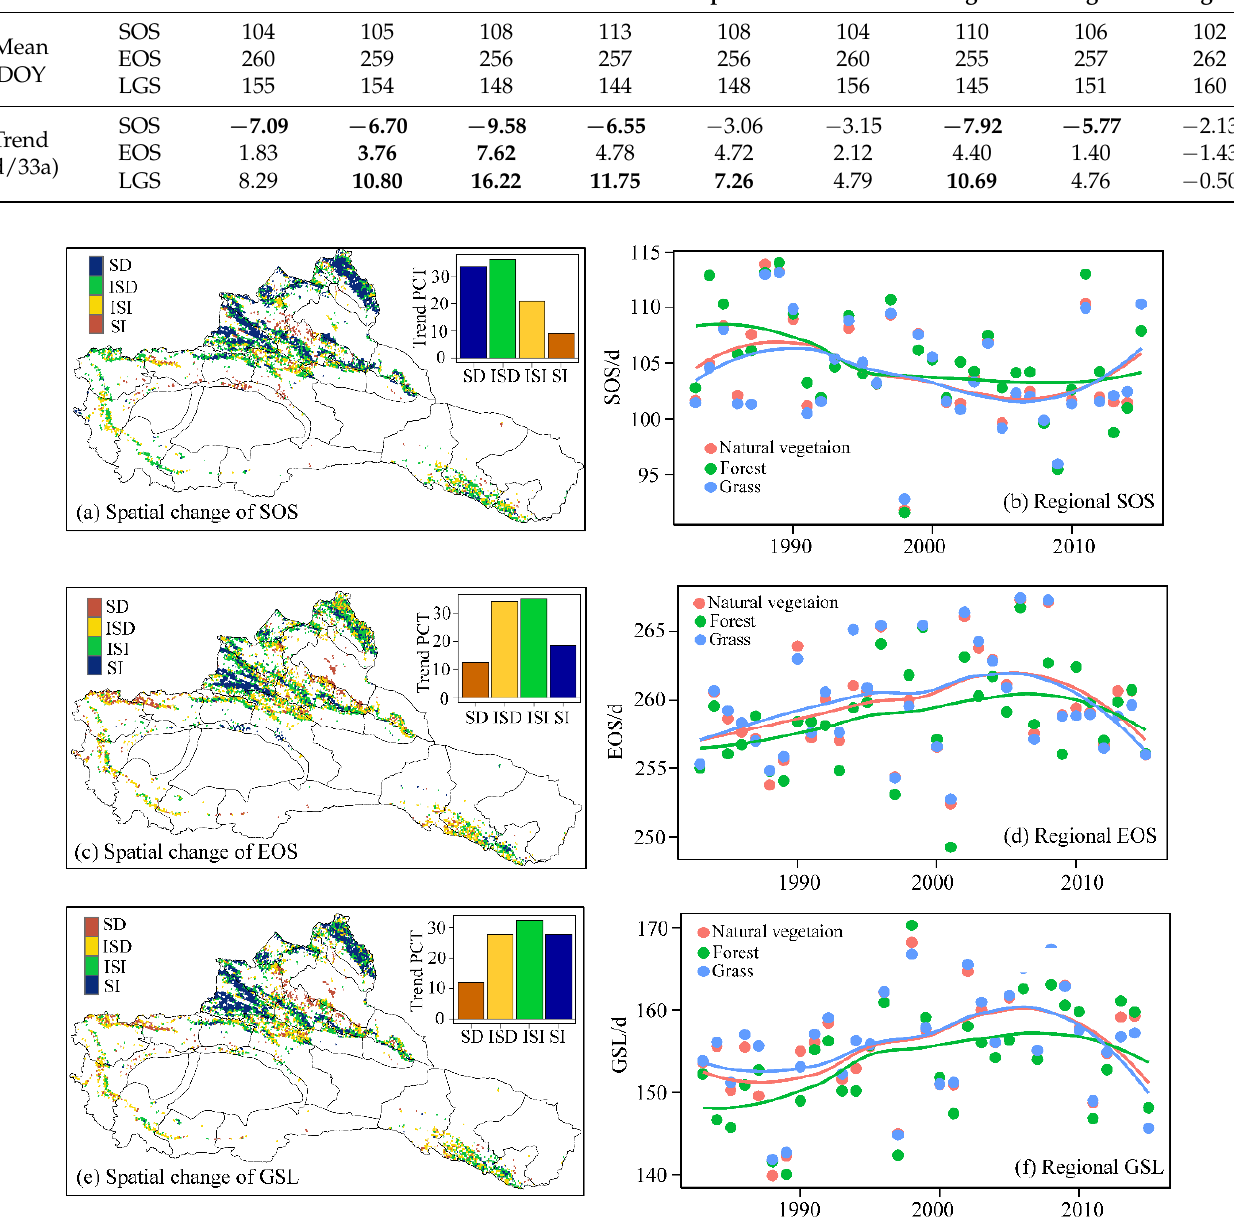
Figure 2. Spatial changes in the start of the growing season (SOS; ( a )), end of the growing season (EOS; ( c )), and growing season length (GSL; ( e )), and temporal changes in SOS ( b ), EOS ( d ), and GSL ( f ) in the arid region of northwestern China (PCT is the abbreviation of percent; SD, signifi- cantly decreasing trend; ISD, non-significant decreasing trend; ISI, non-significant increasing trend; SI, significantly increasing trend). Table 1. Mean and trends (Sen slope β ) in phenological parameters of natural vegetation in the arid region of northwestern China (significant trends at the 0.05 significance level are shown in bold).